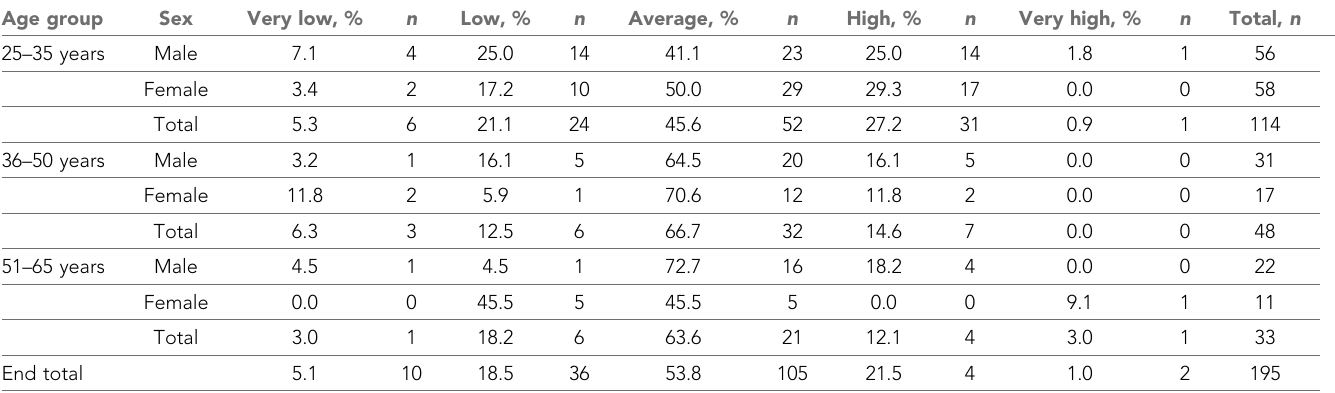
Table 2. Score on engagement by age group and sex Age group